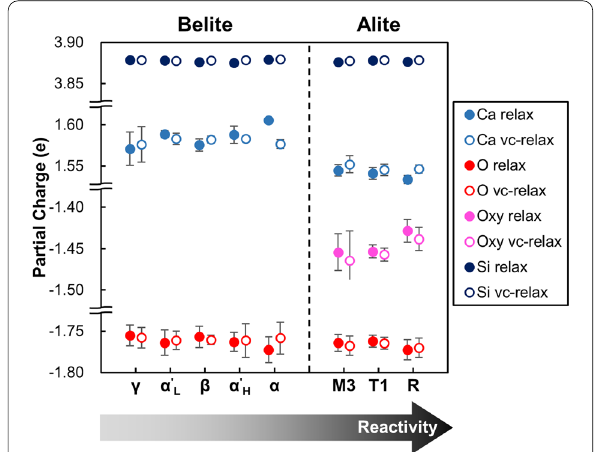
Fig. 4 Partial charge of atoms of belite and alite